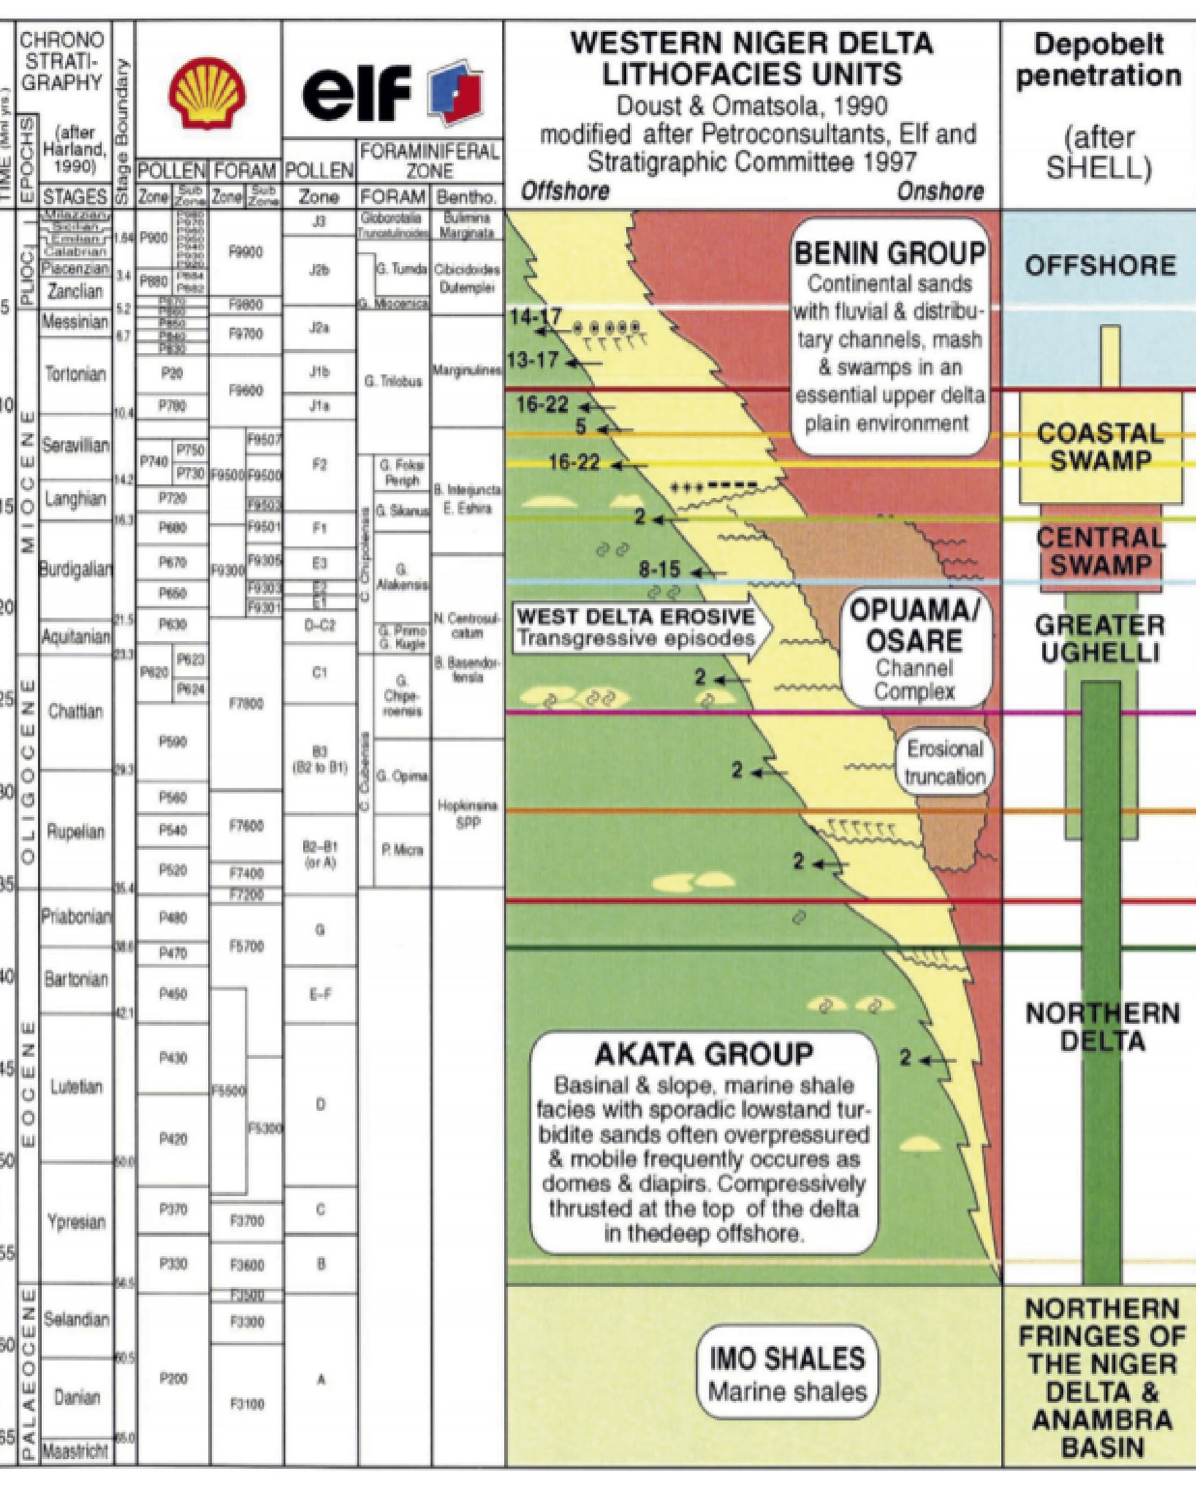
Fig. 3 Stratigraphic data sheet west of the Niger delta (Reijers